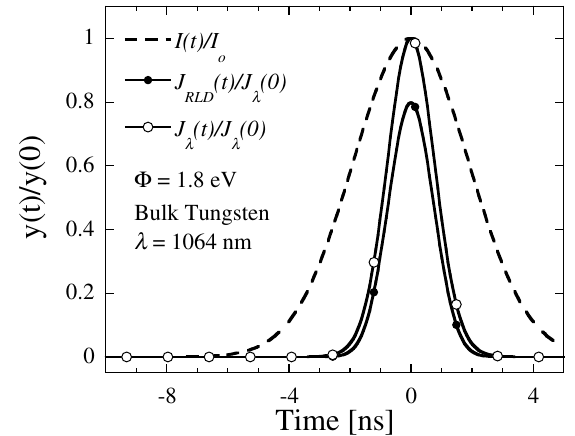
FIG. 17. Same as Fig. 16, but for an incident laser intensity a factor of 10 higher ( (cid:18) E (cid:3) 10 mJ ). The electron temperature now significantly increases, giving rise to a large thermal component of emitted